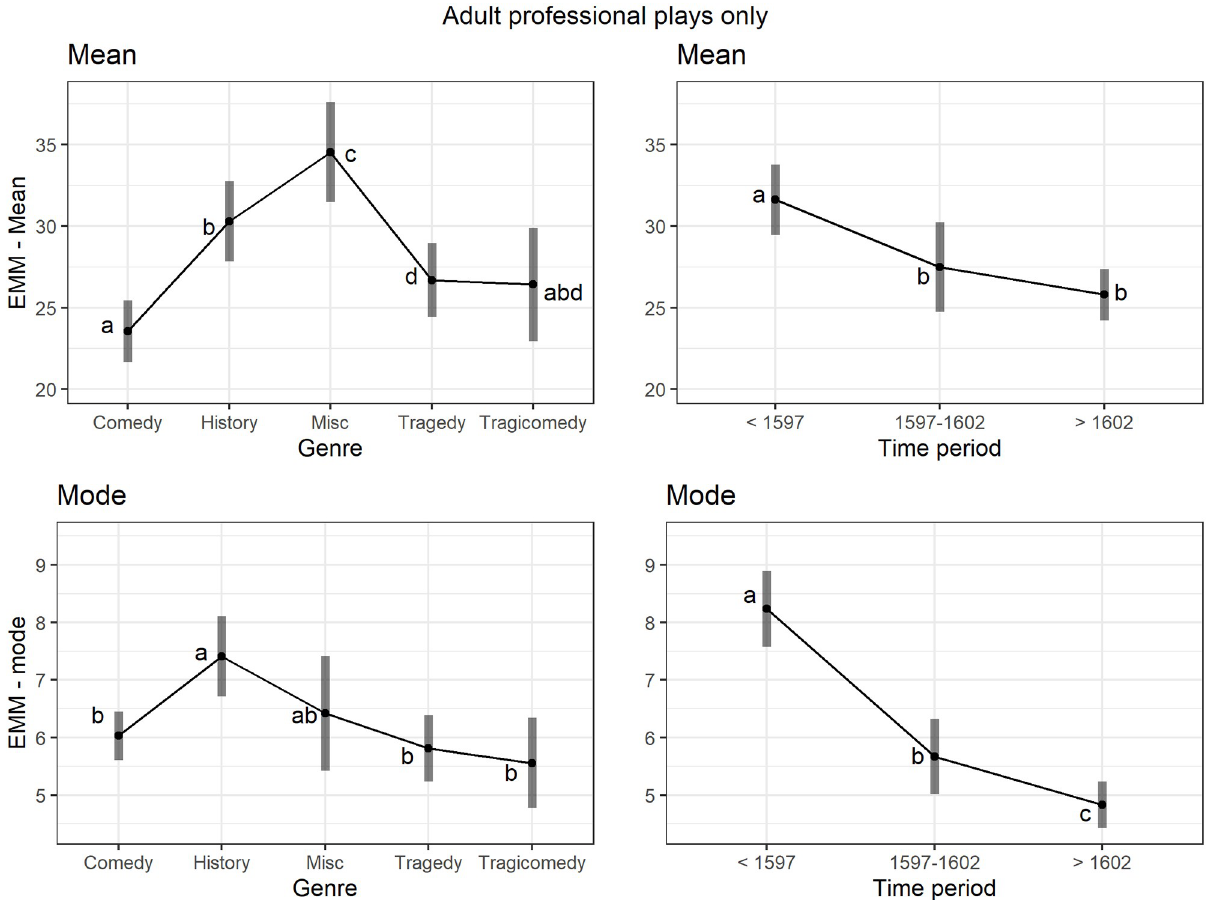
Fig 13. (S1 Fig 16 in S1 File) Comparison of the mean and mode for the genre and time period effects for adult professional play types only. EMMs and 95% Confidence Intervals from the main-effect-only models. Within each plot letters have been added to show which levels are statistically different. Categories with different letters are different; when letters are shared between groups the differences were not large enough to achieve significance.